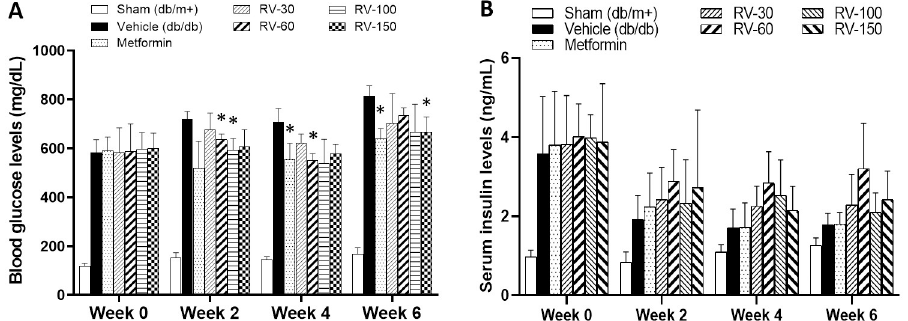
Fig 7. db / db mice treated with 30, 60, 100, and 150 mg/kg/day R-Vera (RV) for 7 weeks. db / db mice receiving metformin or RV showed (A) reductions in BG level and (B) slight improvements in serum insulin level. Nevertheless, no obvious dose-dependent effects on BG and serum insulin levels were found. N = 5 per group. � P < 0.05 compared to vehicle ( db/db ) group with two-way ANOVA.